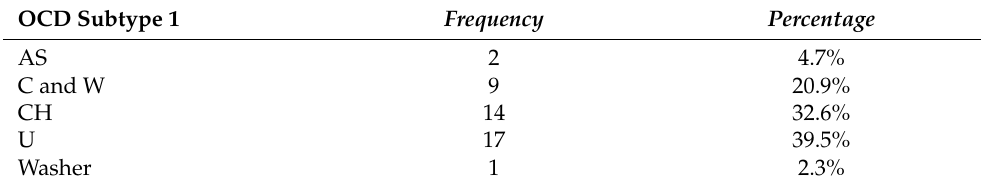
Table 3. Distribution of OCD